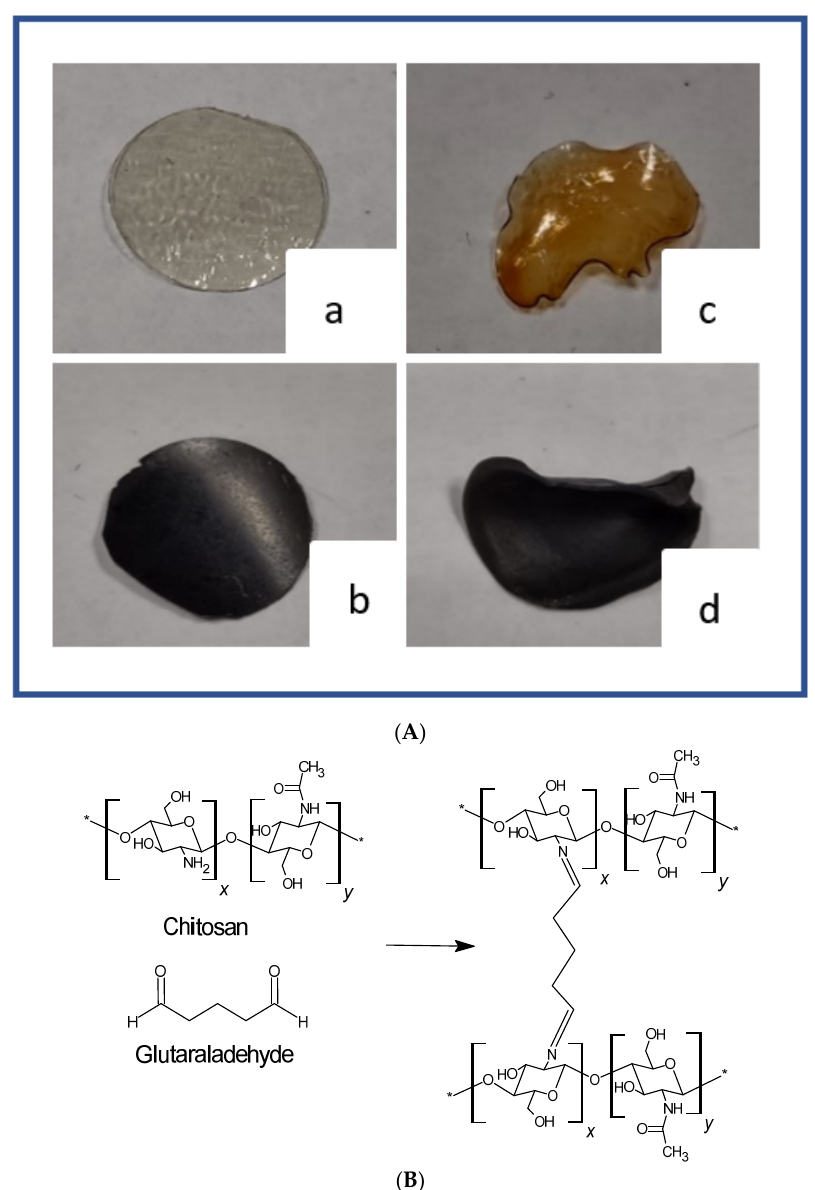
Figure 1. ( A ) Illustration of non-crosslinked CS ( a ) and CS_GO10 ( b ); and crosslinked CS ( c ) and CS_GO10 ( d ). ( B ) Scheme of the crosslinking reaction between chitosan and glutaraldehyde. Table 1. Physical properties of the CS_GO and CS_GO_GLU composites.